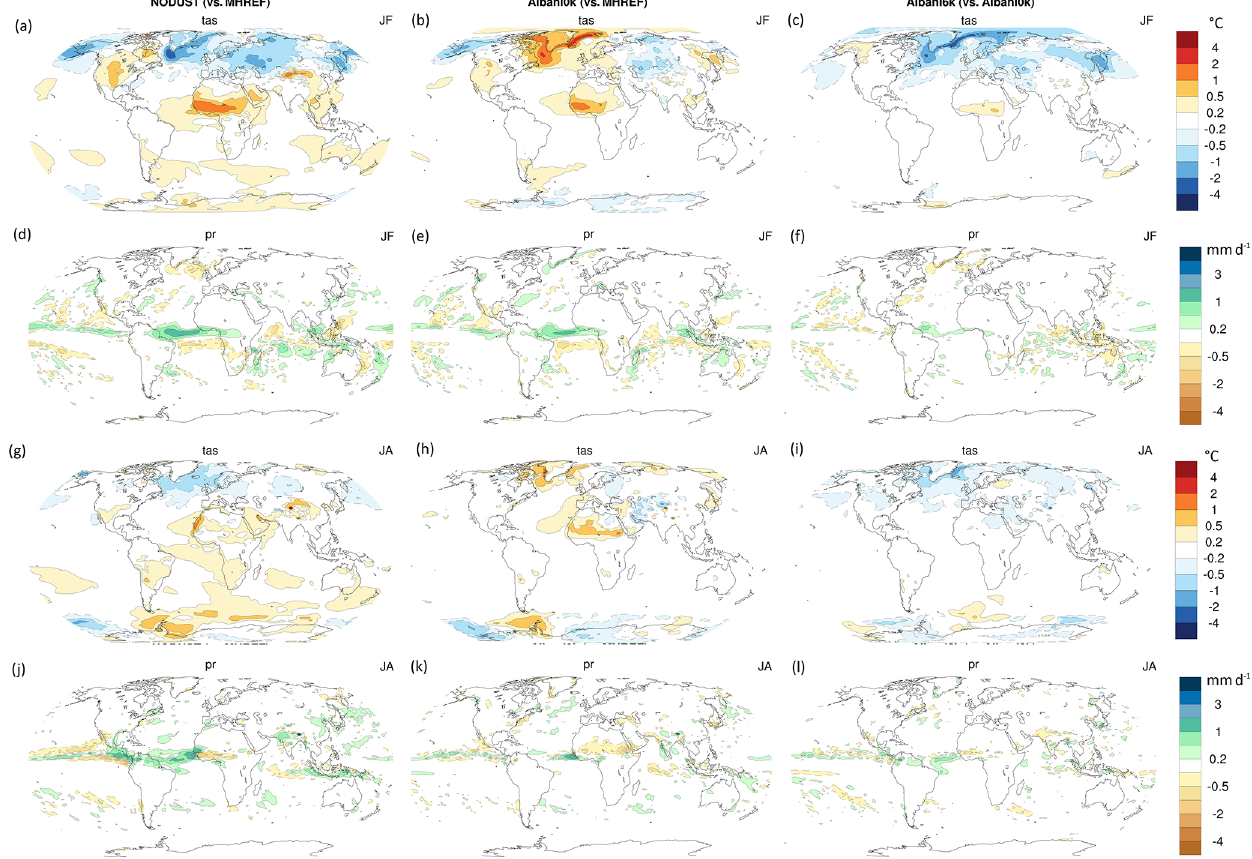
Figure 7. Impact of the different dust forcings on the simulated mid-Holocene climate for (a–e) mean January–February (JF) differences and (g–l) mean July–August (JA) differences. Panels (a) , (b) , (c) , (g) and (i) represent the differences for temperature (tas, ◦ C) and (d) , (e) , (f) , (j) , (k) and (l) for precipitation (pr, mmd − 1 ). The first column highlights the effect of suppressing dust (NODUST–MHREF), the middle column the effect of replacing IPSL pre-industrial dust by Albani’s pre-industrial dust (Albani0k–MHREF) and the last column the effect of mid-Holocene dust considering Albani’s dust files (Albani6k–Albani0k). Note that for direct comparison with the magnitude of the differences induced by the insolation forcing, the legend is the same as in Figs. 4 and